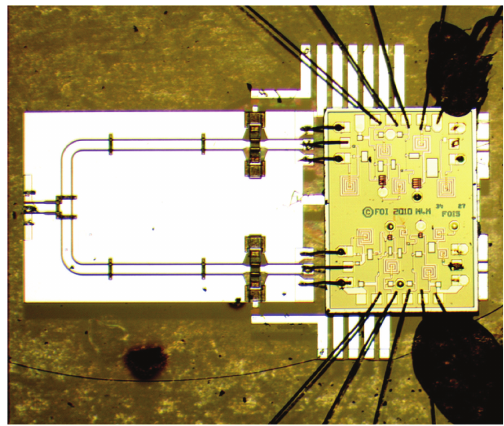
Figure 3: A photograph of a K-band reconfigurable (multifunc- tional) LNA hybrid circuit realised using a MEMS SPDT switch network (to the left) wire-bonded to a dual-LNA GaAs MMIC (to the right) designed for low NF and high linearity,